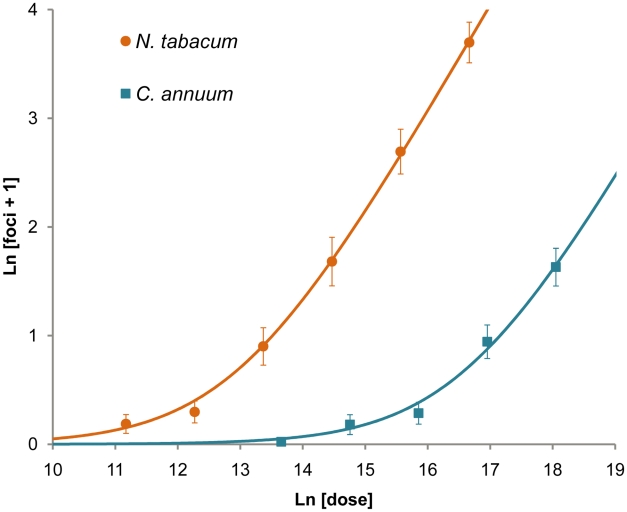
Number of primary infection foci in inoculated leaves at different doses.The ordinate is the mean ln-transformed number of foci of primary infection plus one, with error bars indicating 95% confidence intervals, while the abscise is ln-transformed dose (the number of virions per inoculated plant, as estimated by the number of RNA molecules measured by RT-qPCR). The orange circles and blue squares are data points for N. tabacum and C. annuum, respectively. The orange and blue lines are the fitted IAH dose-foci relationship. A good model fit for N. tabacum (R
2 = 0.713, F
1,21 = 52.091, P<0.001) and C. annuum (R
2 = 0.799, F
1,12 = 47.636, P<0.001) indicates number of foci increase linearly with dose. Note that the data and model taper off as the mean number of foci becomes low due to the ln transformation.